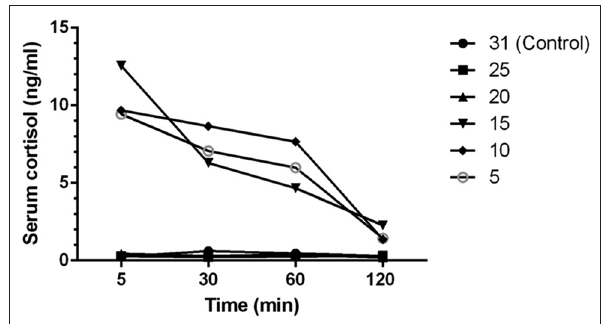
Figure-2: Time-course changes of mean serum cortisol (ng/ml) of E. fuscoguttatu s under different